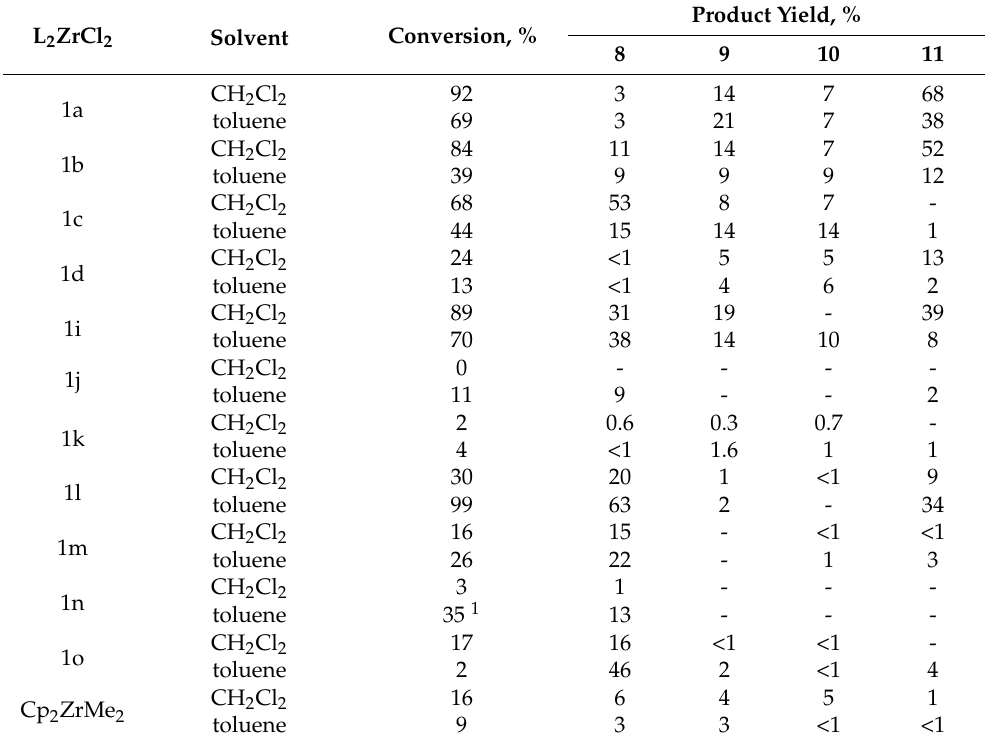
Table 1. Conversion and product yields in the reaction of the oct-1-ene with Me 3 Al in the presence